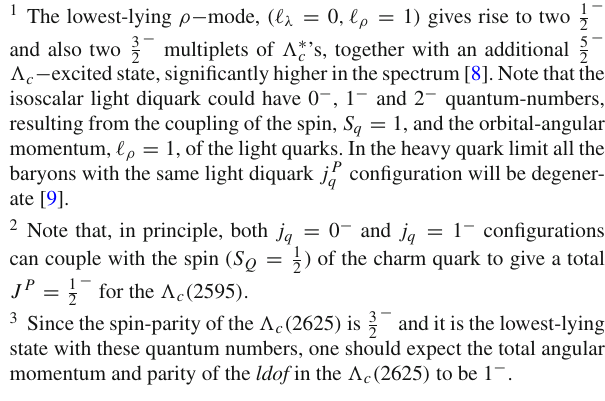
Table 1 Masses and widths of the (cid:2) c ( 2595 ) and (cid:2) c ( 2625 ) reso- nances (MeV units). Thresholds (MeV) of some possible S − wave decay channels are also given. In addition, the thresholds of the three- body channels, after the P − wave decay of the (cid:10)